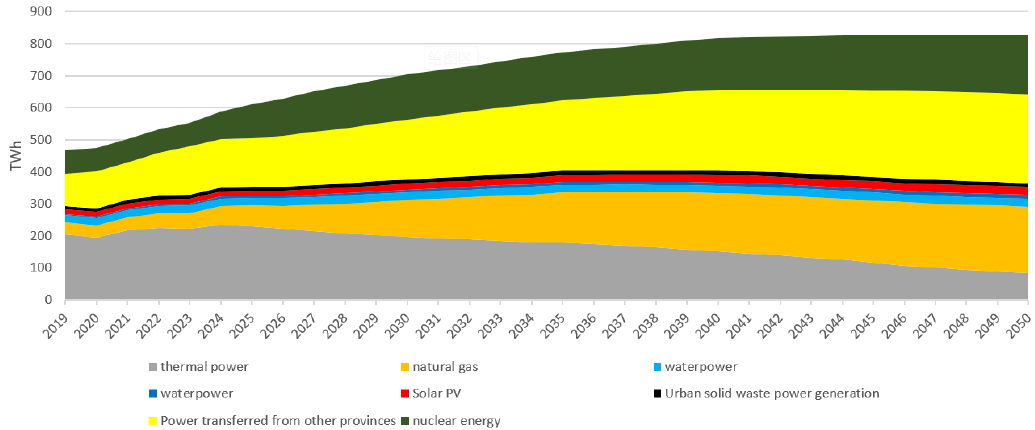
Figure 9. Changes in CO 2 emissions in Zhejiang Province under the carbon pricing scenario.